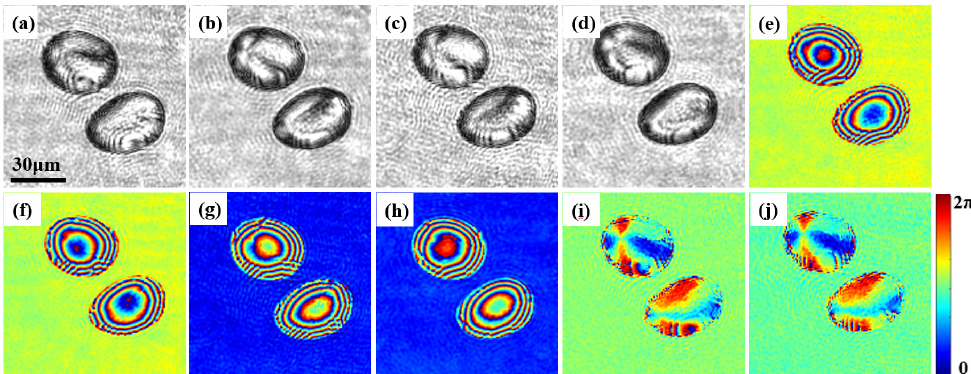
Figure 5. Amplitude and phase distribution of potato starch granules in two orthogonal polarization directions. ( a – d ) The amplitude distributions correspond to Y 11 , Y 12 , Y 21 , and Y 22 , respectively; ( e – h ) are the corresponding phase distributions; ( i , j ) are the phase delays in the two orthogonal polarization directions, respectively.